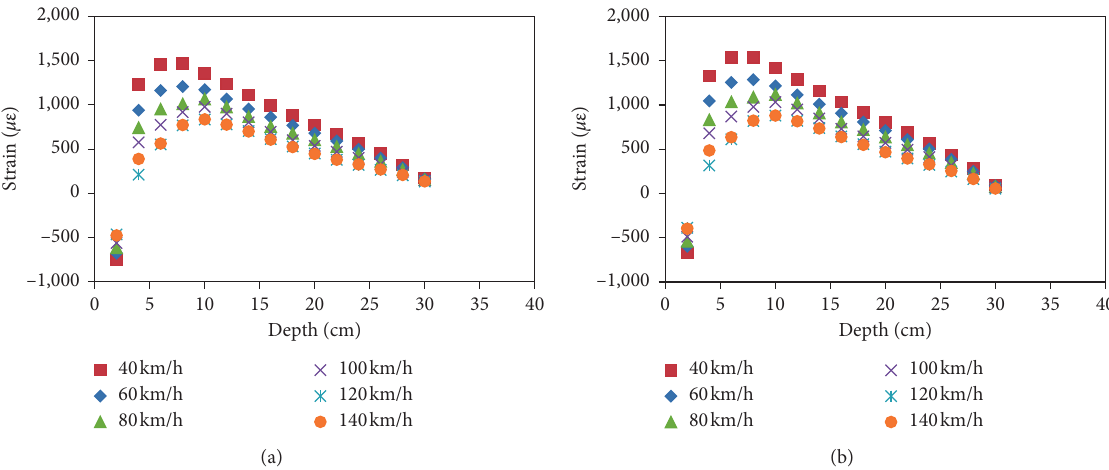
Figure 16: The strains of asphalt layer in (a) flexible pavement and (b) semirigid pavement at higher vehicular